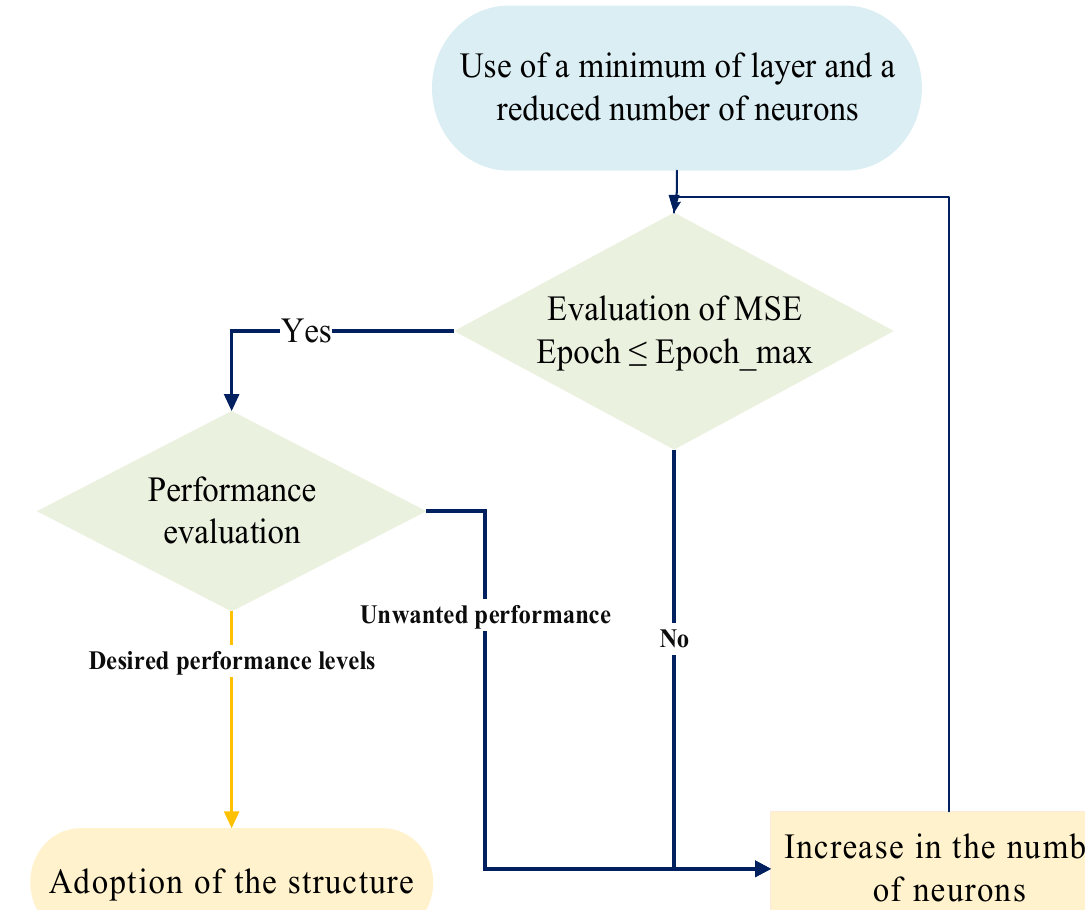
Figure 6. Procedure for the adoption of the ANN structure.